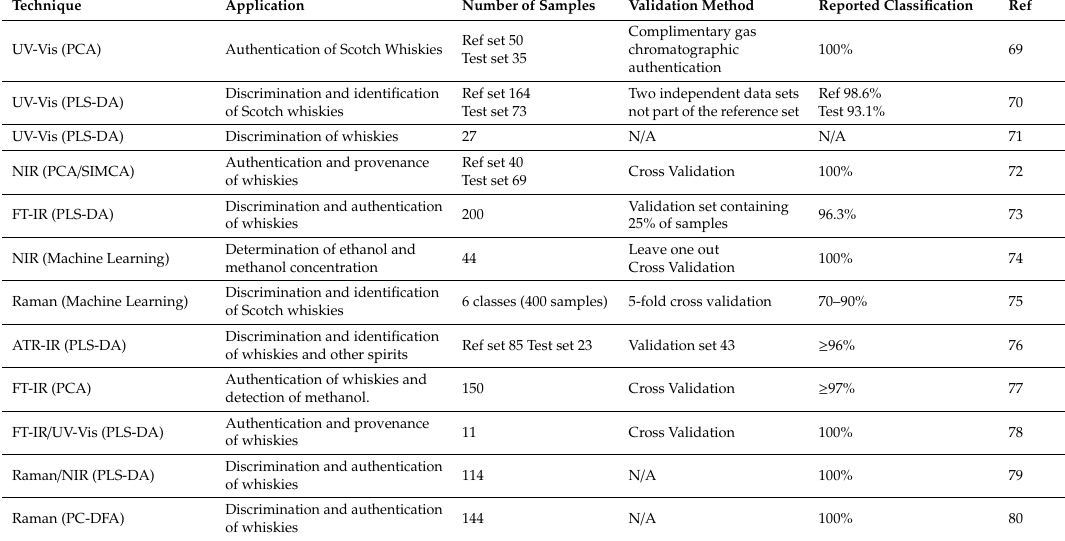
Table 2. Application of spectroscopy and